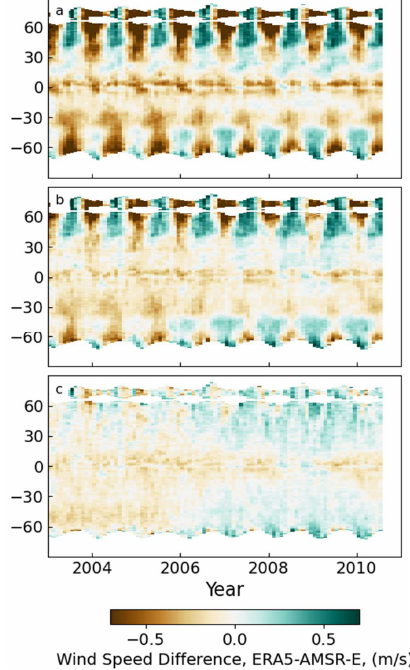
Figure A5. Similar to Figure 9 in the main text, except for AMSR-E. Hovmöller diagrams of the differences between ERA5 and AMSR-E. ( a ) shows the differences relative to ERA5_OSCAR. There are large seasonally modulated differences poleward of about 25 degrees north and south. ( b ) shows the differences relative to ERA5_ADJ. The adjustments applied to ERA5 reduced the ERA5-AMSR- E seasonal differences. After WS adjustments were applied to the AMSR-E winds, the seasonal differences are much reduced ( c ). The remaining differences are mostly less than 0.25 m/s with a small trend over the period.